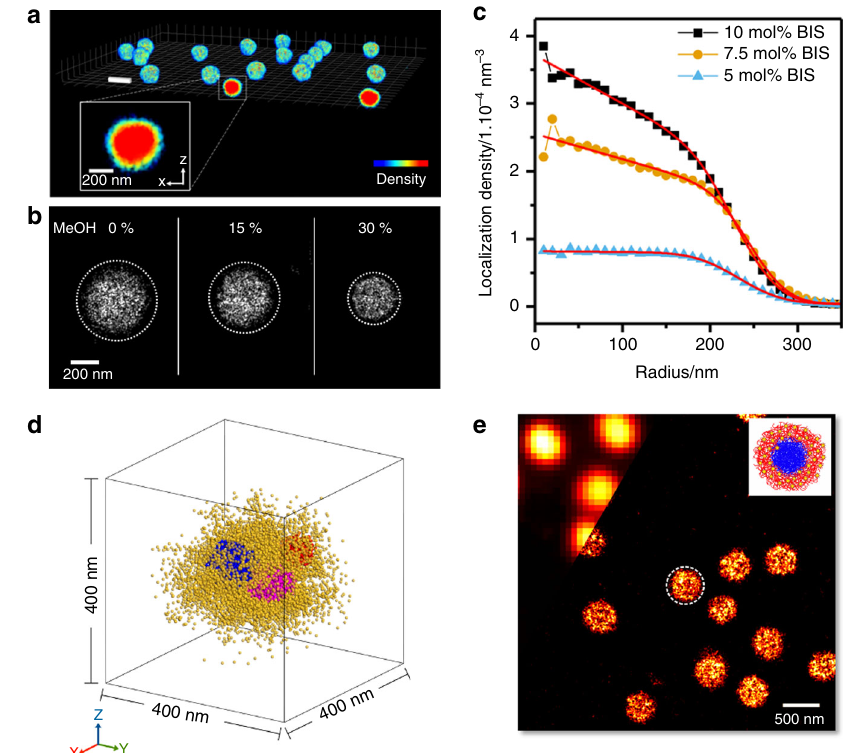
Fig. 4 SRFM characterization of individual microgels. a 3D-dSTORM rendering of individual swollen neutral pNIPAM microgels (BIS 5%) in pure water, weakly adsorbed to a glass substrate ( T = 22 °C). The glass coverslips were treated with piranha solution (a 4:1 solution of sulfuric acid and hydrogen peroxide), which results in a highly hydrophilic surface (water contact angle 0° as reported in ref. 128 ). Inset: enlarged color-coded view of the internal density distribution. b Two-dimensional dSTORM of the same microgel particle and deswelling upon addition of methanol (MeOH). The dashed circles indicate the hydrodynamic diameter. Both panels adapted from ref. 58 (Fig. 2), with permission from Elsevier, Copyright (2016). c Density pro fi le of dye localizations for similar neutral pNIPAM microgels suspended in pure water. The panel shows the results from a dSTORM study of microgels synthesized with different amounts of cross-linker (BIS = 5 – 10%). For BIS concentrations above 5%, the data suggest a linearly increasing density toward the particle center. Reproduced from ref. 86 with permission from The Royal Society of Chemistry. d Single-molecule localization microscopy of near-spherical swollen microgel particles at 20 °C adsorbed to a polylysine-coated glass coverslip. The fl uorescence localizations are determined for a small fraction of microgel cross-linker that has been dye-labeled. The (red, blue, and magenta)-color-labeled patches indicate clusters of increased cross-link density, while the localizations in the surrounding matrix are depicted in yellow, image reproduced with permission from ref. 88 (Copyright Royal Society of Chemistry, 2018). e dSTORM imaging of swollen pNIPAM-core – pNIPMAM-shell microgels in water deposited on a polylysine-coated glass coverslip. Inset: sketch of the particles. In the left upper corner, a part of the diffraction-limited image is shown. The dashed circle indicates the hydrodynamic diameter measured by DLS. The graphic was reproduced with permission from ref. 57 (Copyright American Chemical Society,